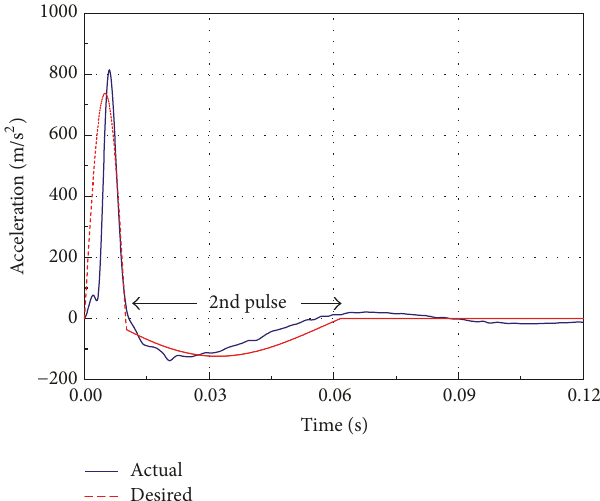
Figure 10: Comparison test and simulation results (Test #1: 0 A).